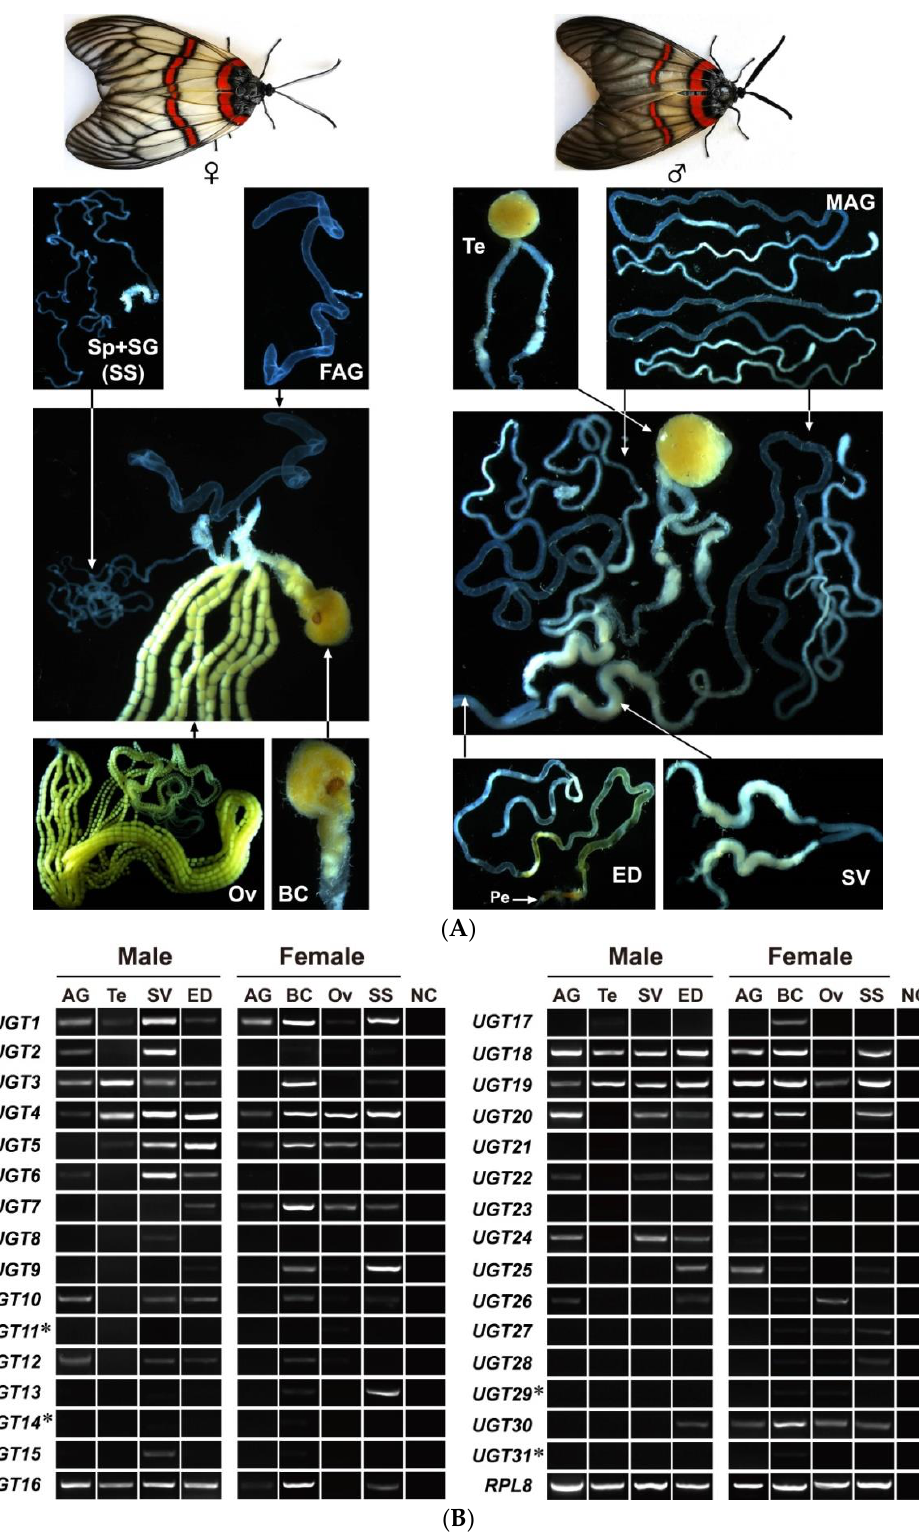
Figure 5. Expression profile of 31 full-length UGT genes in reproductive tissues of A. yunnanensis . ( A ) Reproductive systems of female and male moths. ( B ) Expression of UGT genes in eight reproductive tissues. Asterisks mean that the transcription of the genes was not detected in tissues. MAG, male accessory glands; Te, testes; SV, seminal vesicles; ED, ejaculatory ducts; FAG, female accessory glands; BC, bursa copulatrix; Ov, ovaries; and SS, spermathecae with spermathecal glands.